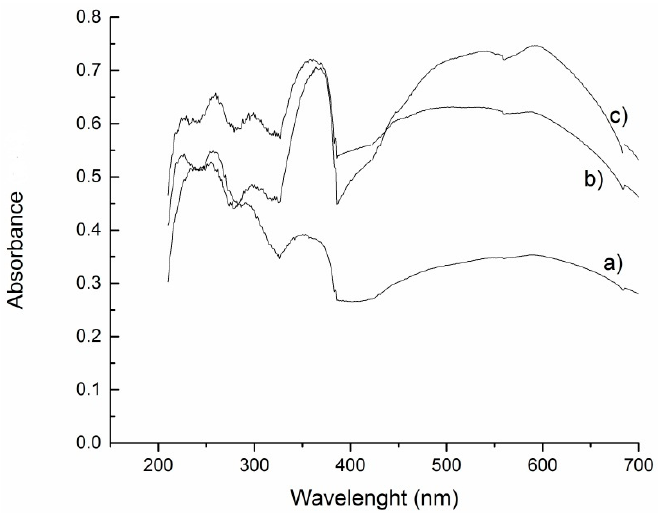
Figure 5. DRS UV-Vis signals for the prepared catalysts. ( a ) Ag1Z, ( b ) Ag5Z and ( c ) Ag10Z.